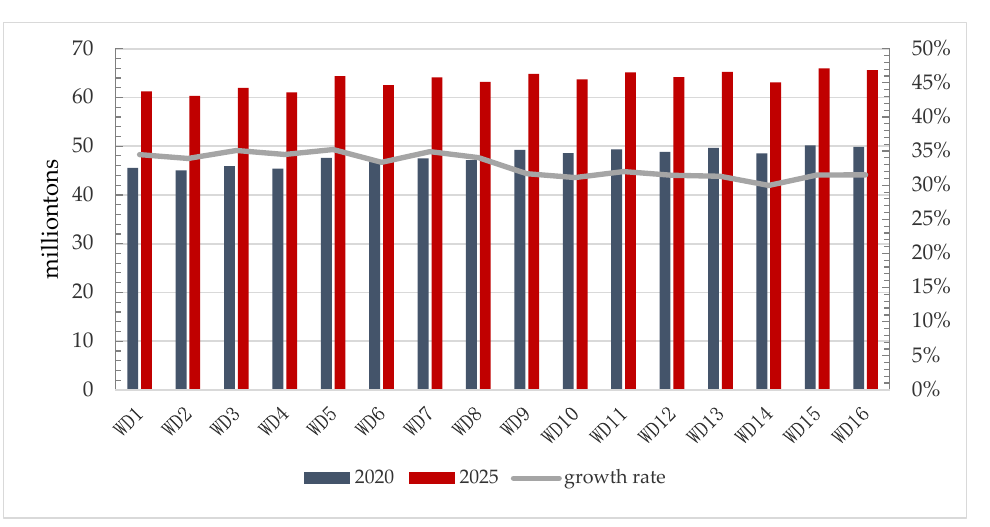
Figure 5. The predictions of power CO 2 emissions for the weakened development scenario in 2020 and 2025.